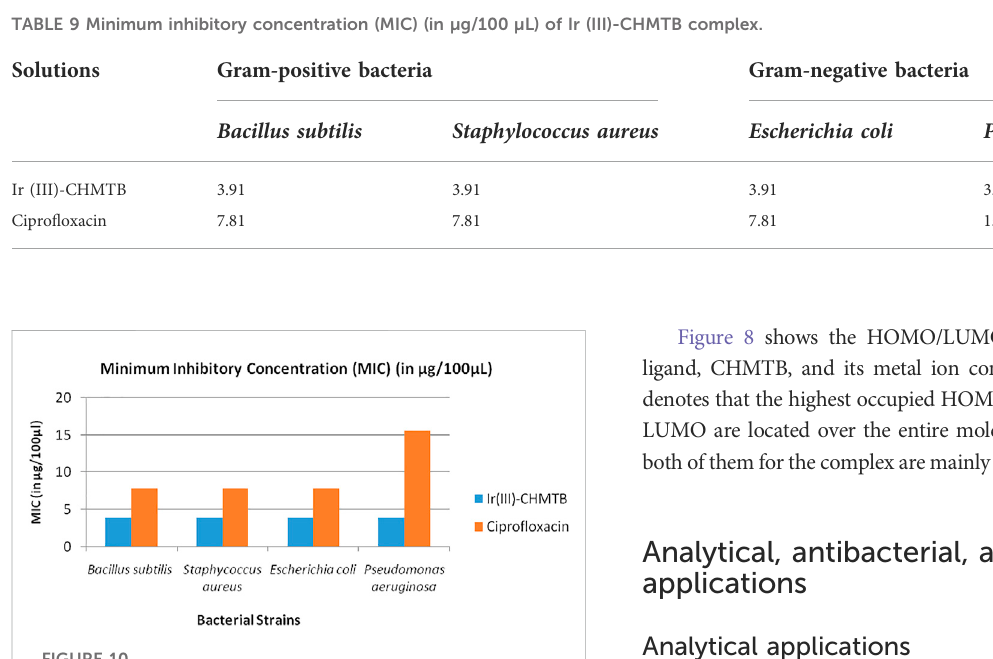
FIGURE 10 Minimum inhibitory concentration of Ir (III)-CHMTB complex against bacterial strains.